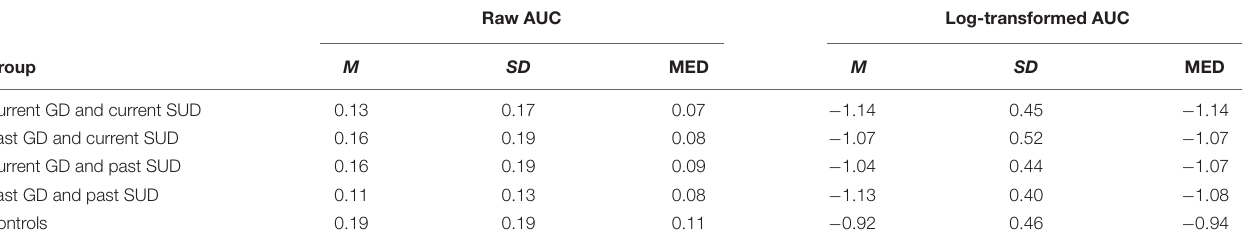
TABLE 3 | Descriptive statistics of the raw and transformed area under the delay discounting curve.